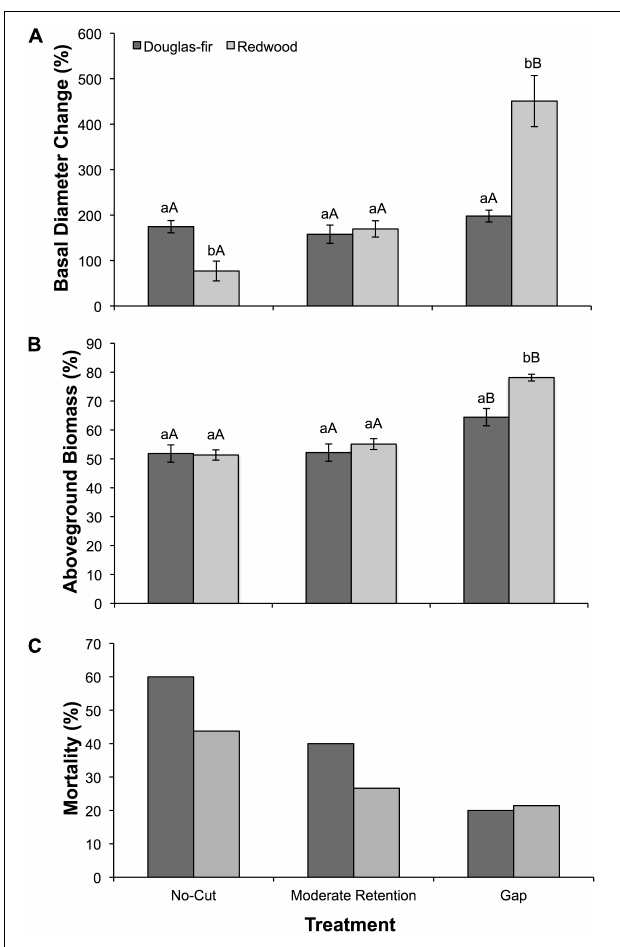
FIGURE 3 | (A) Mean ( ± SE) change in basal diameter as a percent of initial basal diameter, (B) mean ( ± SE) aboveground biomass accumulation as a percent of total biomass (above- plus belowground), and (C) total mortality as a percent of initial cohort after 2 years of growth for Douglas-fir and redwood seedlings planted after partial harvesting in Maple Creek, CA. Seedlings were planted (15 seedlings per species per treatment) in early spring 2015 and were harvested, including root systems, in November 2016 for biomass quantification. The mortality percentages shown here are cumulative for 2015 and 2016. Within a treatment, species not sharing the same lowercase letters are significantly different; within a species, treatments not sharing the same uppercase letters are significantly